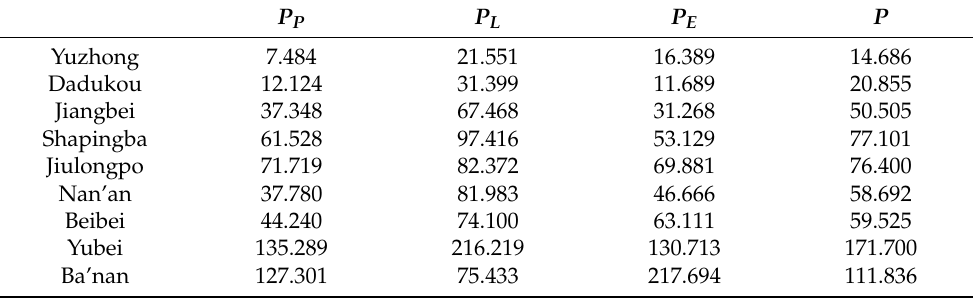
Table 12. The value of LRCC in the 9 county-level administration districts in 2019. (unit: 10,000 person). P P P L P E P